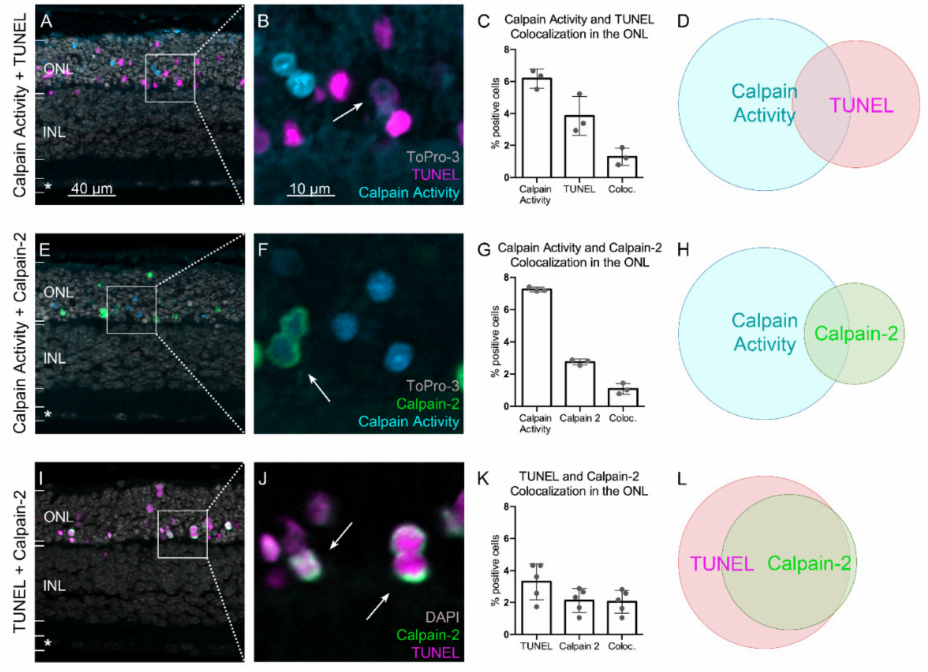
Figure 4. Colocalization of the TUNEL assay, calpain activity assay, and calpain-2 immunostain- ing. ( A – D ) Comparison between calpain and calpain-2 activation. ( E – H ) Comparison between calpain activity and the TUNEL assay. ( I – L ) Comparison between calpain-2 activation and the TUNEL assay. The arrows highlight cells showing colocalization. ( D , H , L ) Venn diagrams visualizing the relative proportion of cells positive for the respective staining, as well as the overlap between different stainings (colocalization). Images representative of results obtained from three to five independent retinal explant cultures derived from the rd1 mouse model. Error bars indicate STD. ONL = outer nuclear layer, INL = inner nuclear layer, asterisk = ganglion cell